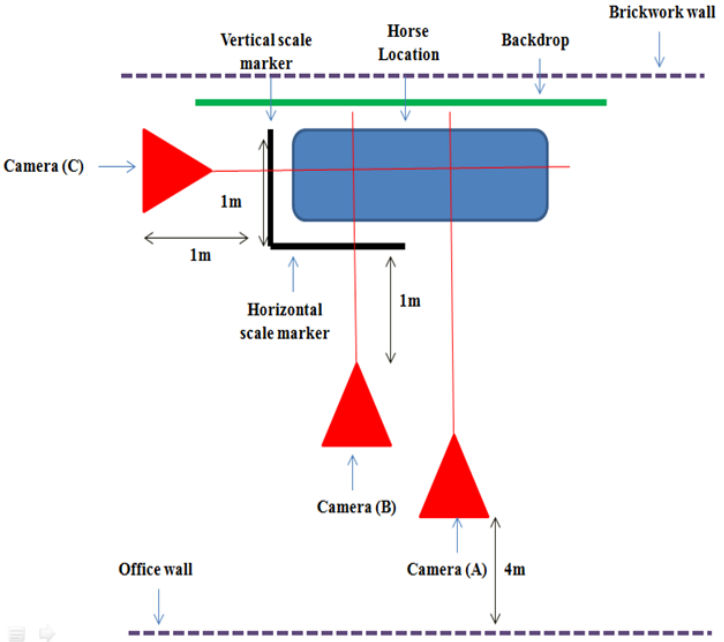
Figure 1. Layout of cameras, scale markers, backdrop, and positioning of the horse for digital image